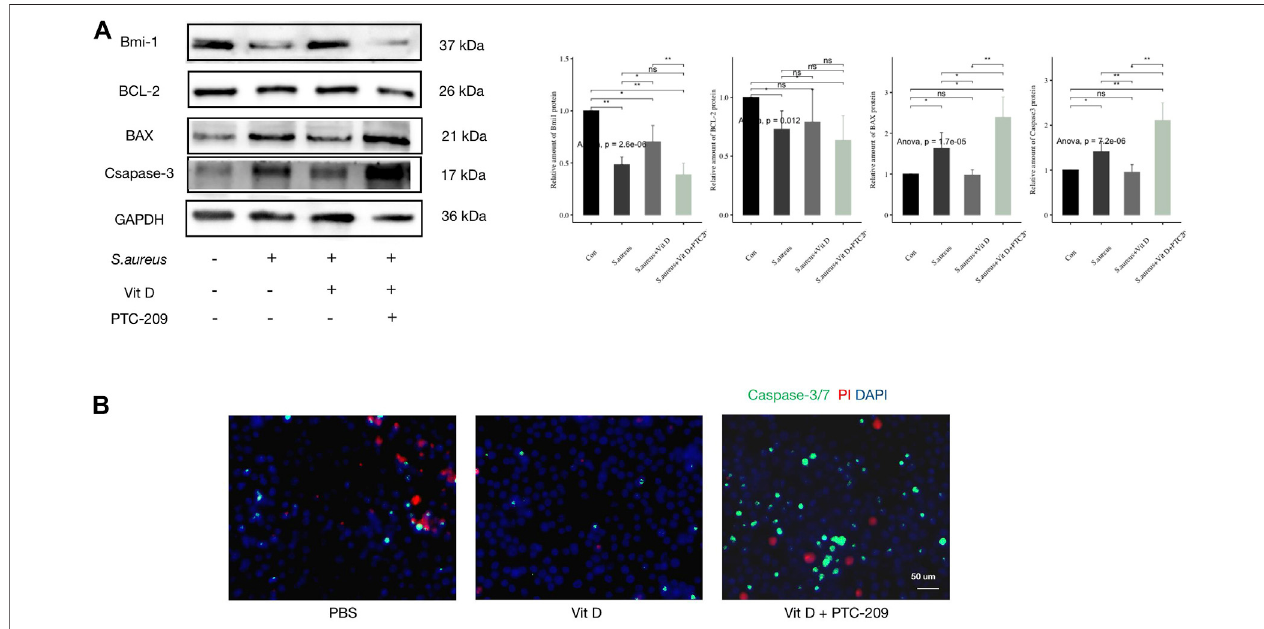
FIGURE 6 | Inhibition of Bmi1 weakened the protective effect of vitamin D on macrophages. (A) Result of western blotting for apoptosis-related proteins. (B) Apoptosis detection, caspase-3/7 (green) and PI (red). Magni fi cation, ×400. “ ns ” for not signi fi cant, * p < 0.05, ** p < 0.01, and *** p < 0.001.